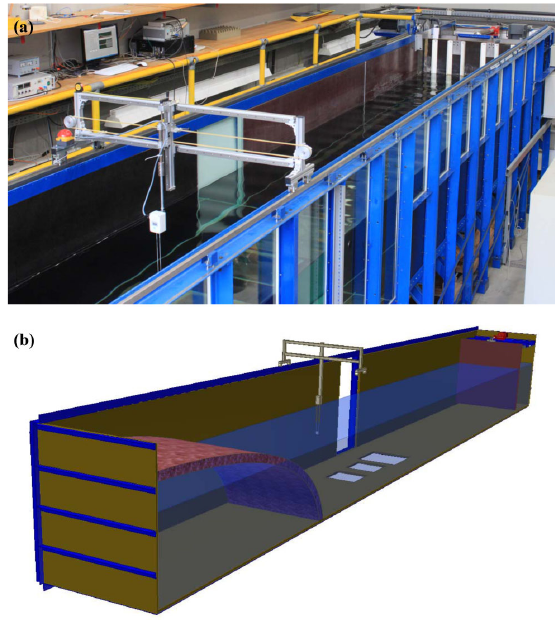
FIG. 1. Higher-order Akhmediev-Peregrine rational solution of the NLS given by Eqs. (5)–(8) with the following background: c 1 . The maximal amplification of five above the back- 0 ¼ ground wave can be observed at X ¼ 0 and T ¼ 0 .